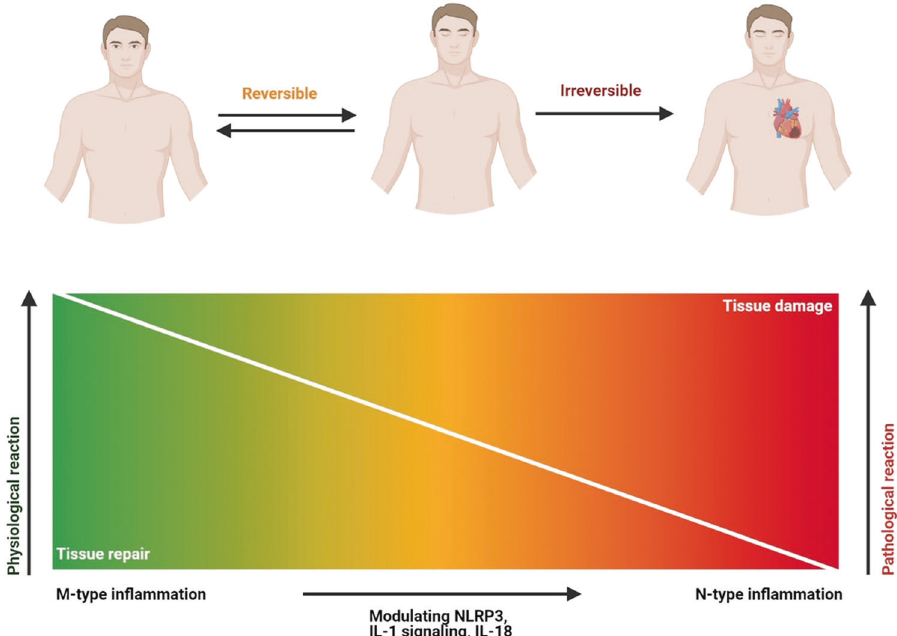
Fig. 7 Bene fi cial effects of acute in fl ammation and deleterious effects of chronic in fl ammation. Acute in fl ammation (M-type) is a bene fi cial process to destroy pathogens and initiate tissue repair. However, chronic in fl ammation (N-type) is a pathological condition that lasts for a long time, leading to tissue damage. Both types of in fl ammation can be modulated by the in fl ammasome Box 2 Key points (cid:129) Double-edged sword : The studies show that the role of in fl ammasomes in the pathogenesis of diseases is bidirectional, and the outcomes can be either good or bad depending on the types and stages of disease, as well as the genetic